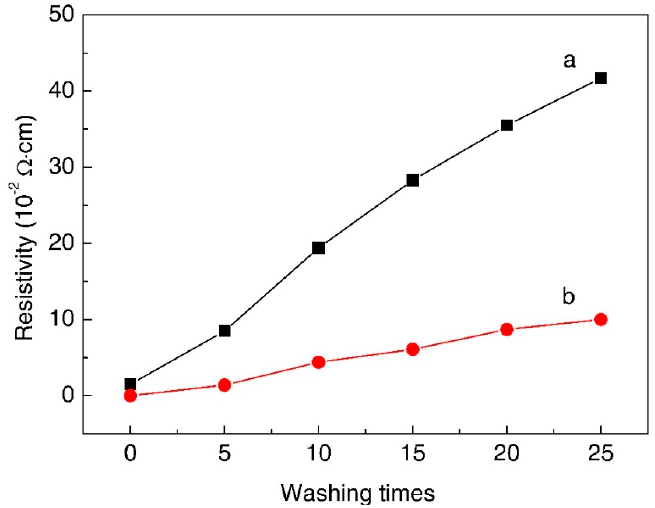
Figure 8. Influence of washing times on the resistivity of different fibers: (a) electroless silver-plated fiber; (b) electroplated silver-plated fiber. fiber; (b) electroplated silver-plated